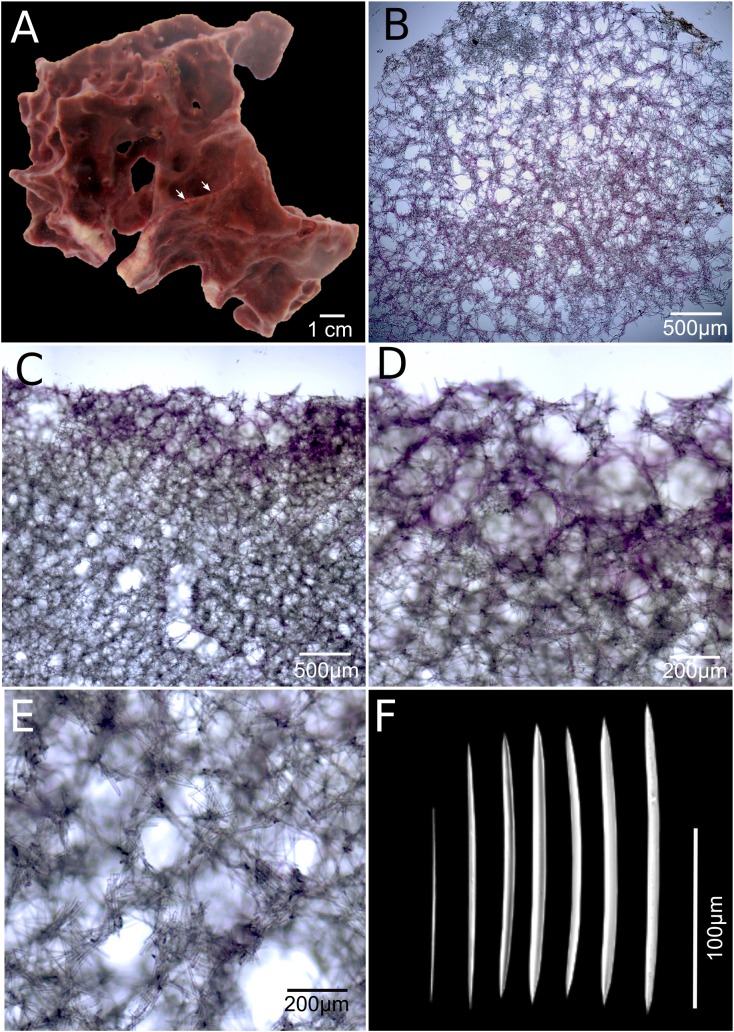
Neopetrosia cristata sp. nov.Holotype (UF3859) (A) ex situ image of live sponge specimen; (B) tangential section of the ectosome (LM); (C) perpendicular section through the ectosome and choanosome (LM); (D) close-up of perpendicular section through the ectosome (LM); (E) close-up of perpendicular section through the choanosome (LM); (F) variation of oxeas (SEM).